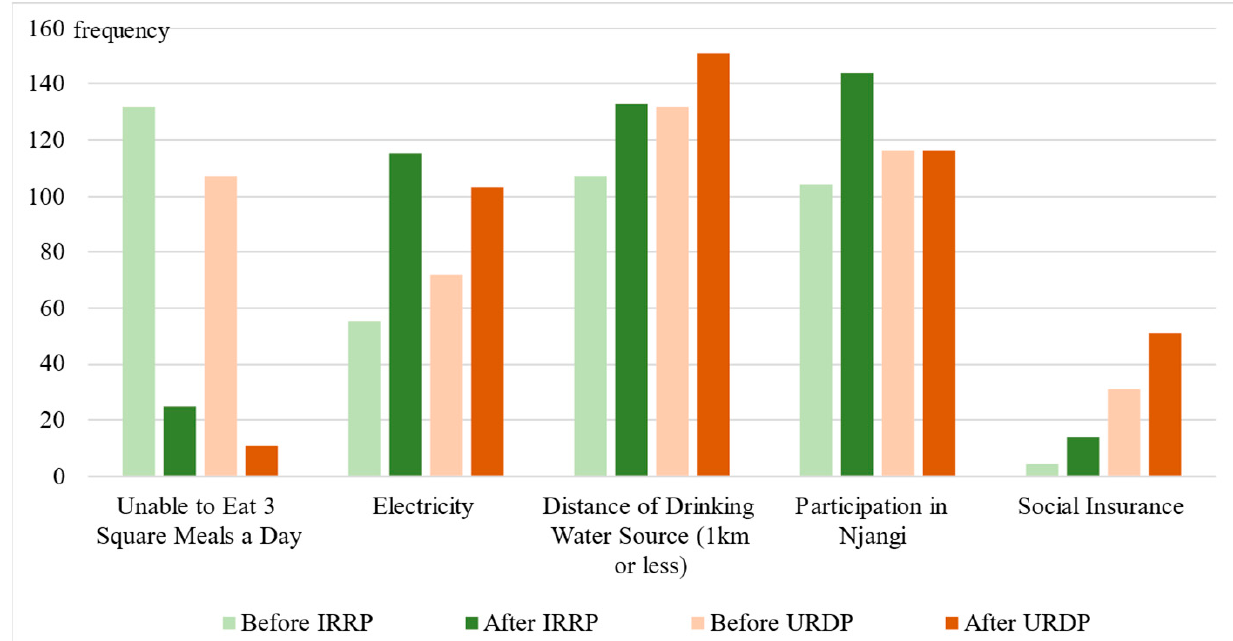
Figure 3. MPI display before and after JICA projects (living standards and social protection schemes).